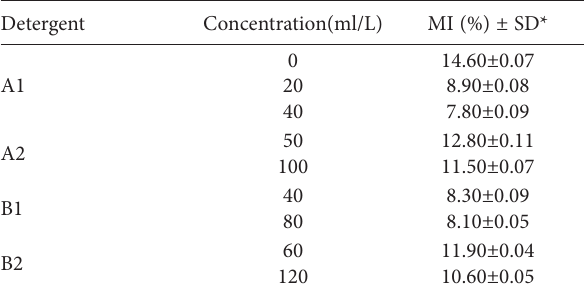
Table 3. Mitotic index percentages calculated for the detergents A1, A2, B1 and B2 after 72 h. treatment.